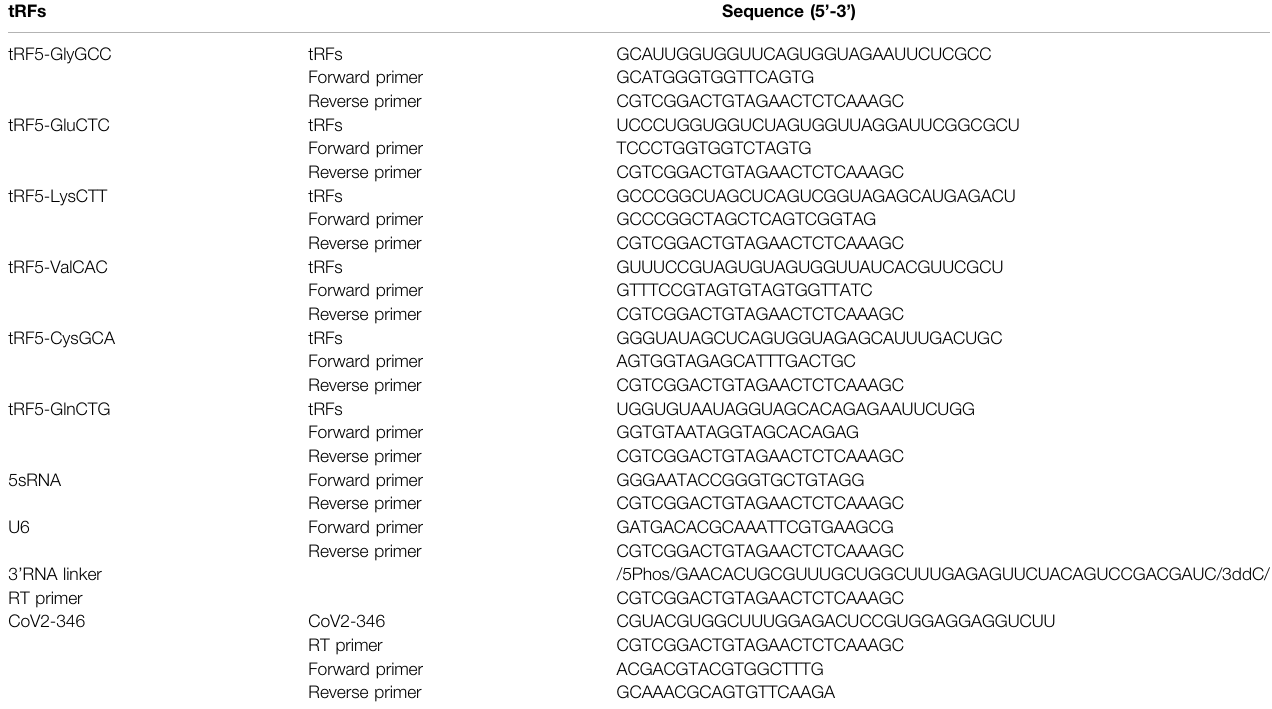
TABLE 1 | Sequence information for tRF5s, RNA linker, RT primer, qPCR primers and PCR primers.